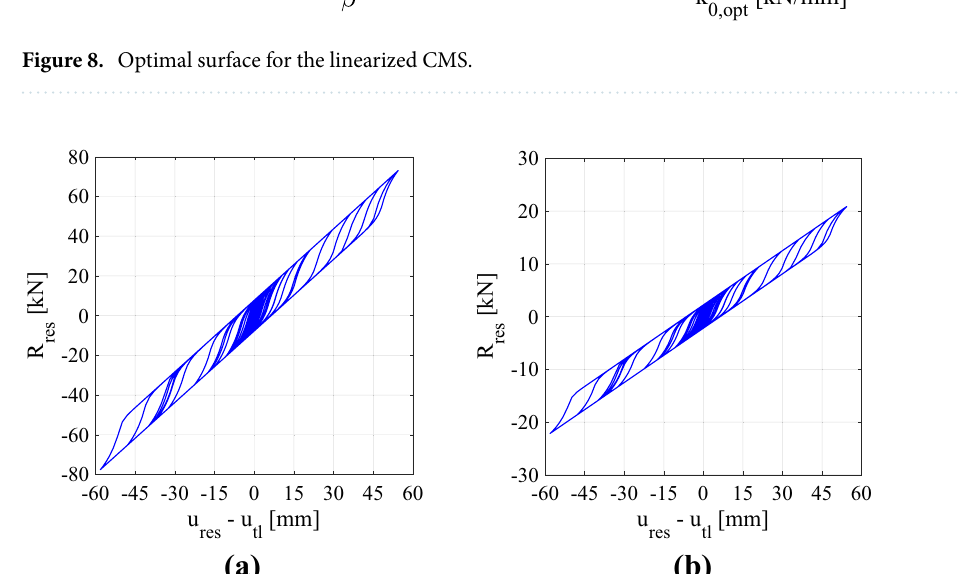
Figure 9. Hysteretic loops of the one-layer CMS hysteretic damper for A = 1, β = 0.9 and γ = 0.1. The resonators are equipped with the ( a ) optimal and ( b ) minimum numbers of wire